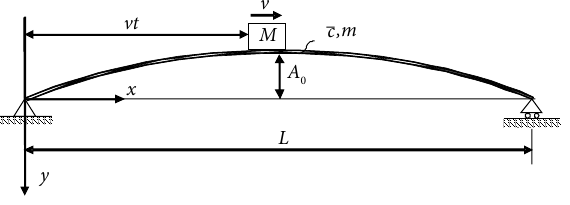
Fig. 1. Slightly curved bridge under a moving mass